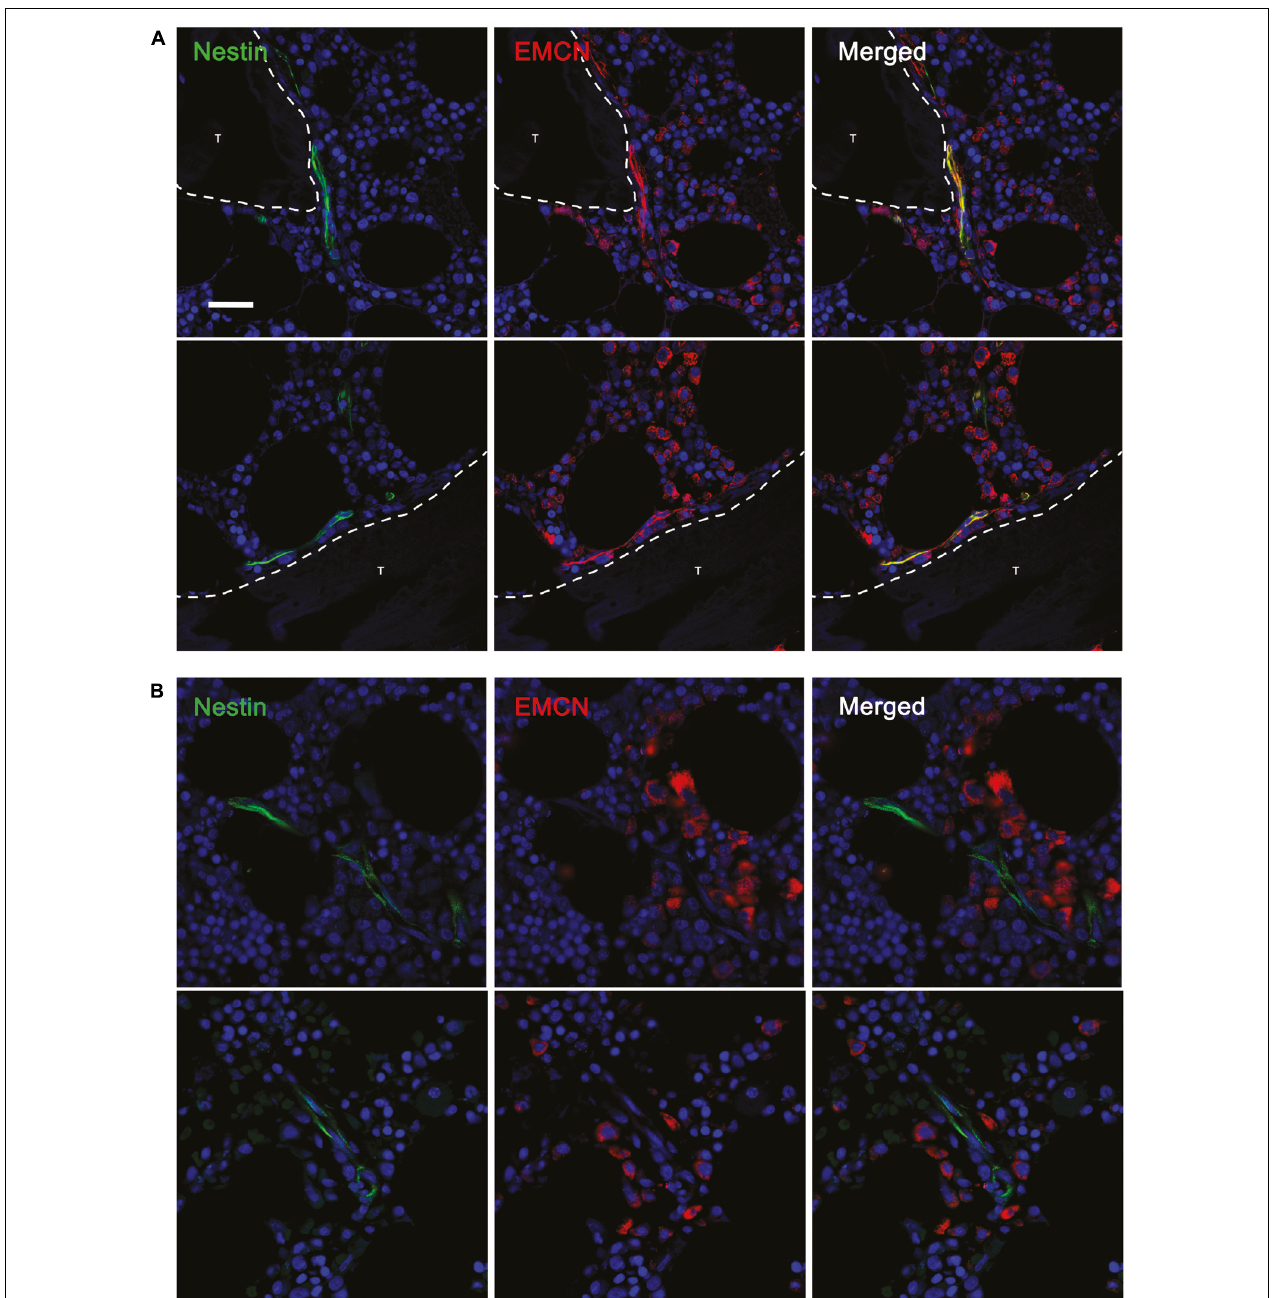
FIGURE 4 | EMCN was detected only in NCLTs in close proximity of the bone line. (A) Most NESTIN (green)–positive NCLTs, detected in proximity of the bone line ( < 10 µ m), showed positive stain for ENDOMUCIN (EMCN, red). (B) Conversely, when a bone trabecula was not detected in the FOV of NCLTs, this latest resulted negative for EMCN (T = bone trabecula, scale bar: 20 µ